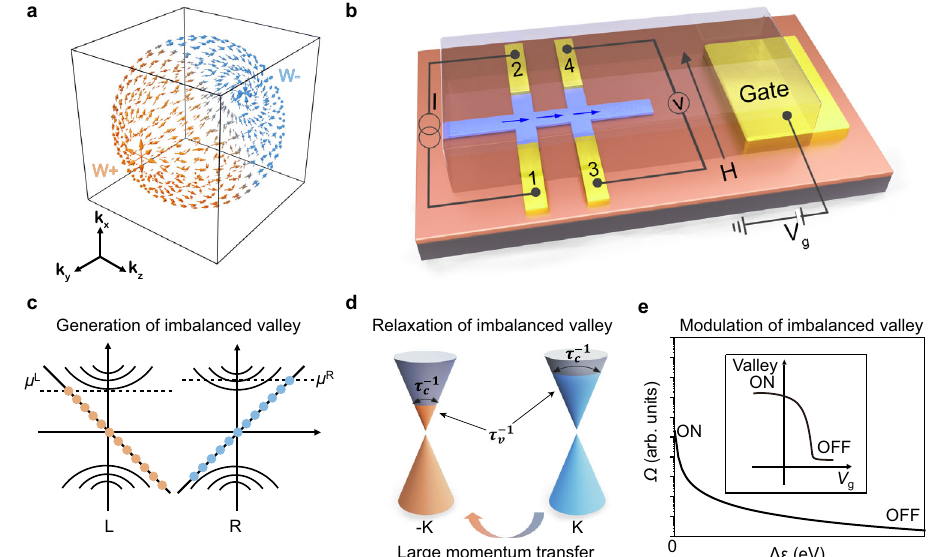
Fig. 1 | Room-temperature valley transistors based on Weyl materials. a Non- trivialBerrycurvatureintheWeylmaterials.ThevectorplotsoftheBerrycurvature connectWeylpoints(W+andW-)inthemomentumspace. b Schematicillustration of the device structure of valley transistor with Weyl semiconductor. In this non- local structure, we apply constant current ( I ) through terminal 1 – 2 and detect the valley diffusion (blue arrow) through terminal 3 – 4 voltage ( V ). Electrostatic gating voltage( V g )isusedforcontrollingtheFermilevel( E F )andBerrycurvature. H isthe applied magnetic fi eld. c Generation of imbalanced valley based on the chiral